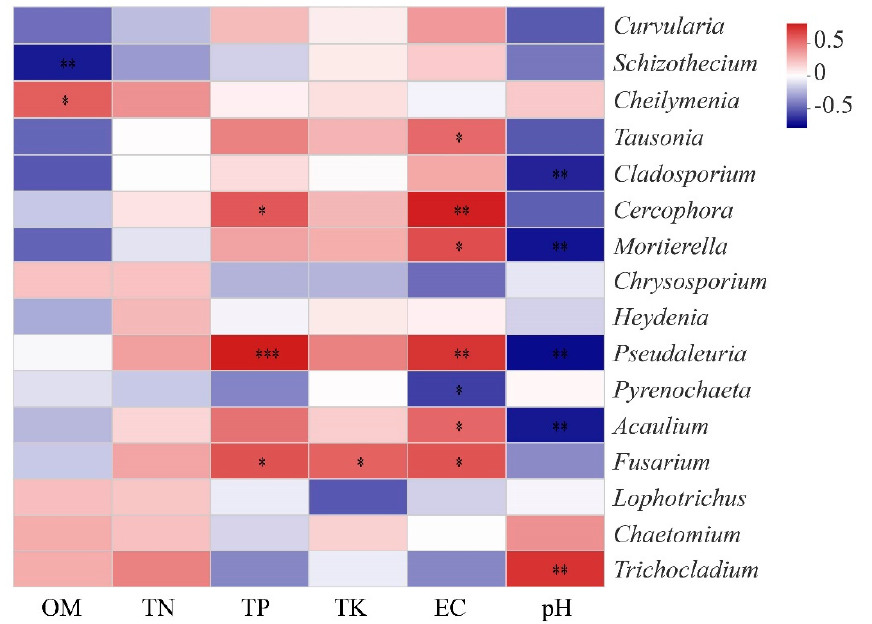
Figure 5. Spearman correlation heatmap analysis between soil fungal genera and soil chemical properties among different CTM cycles. TN = soil total nitrogen content; TP = soil total Phosphorus content; TK = soil total potassium content; EC = electrical conductivity; OM = soil organic matter content. *** p < 0.001; ** p < 0.01; * p < 0.05.